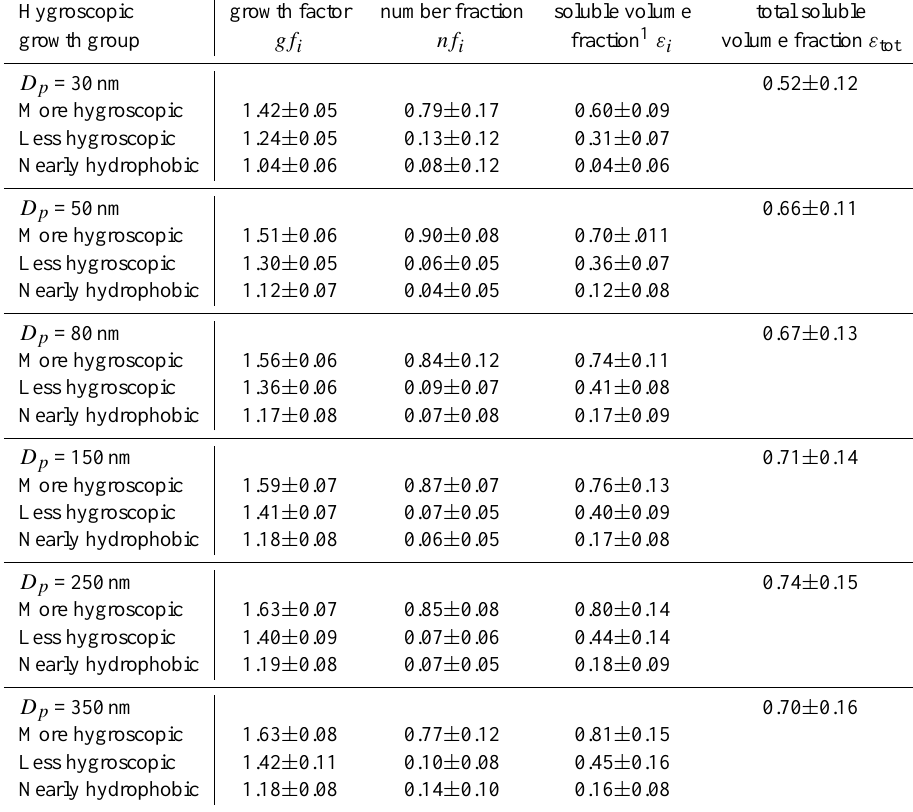
Table 2. Mean hygroscopic diameter growth factors, number fractions, and soluble volume fractions (based on a simplistic two-component model assuming insoluble matter and ammonium sulphate only) of each hygroscopic growth group during ARIADNE. The total soluble volume fraction and standard deviations of the mean are added for completeness.